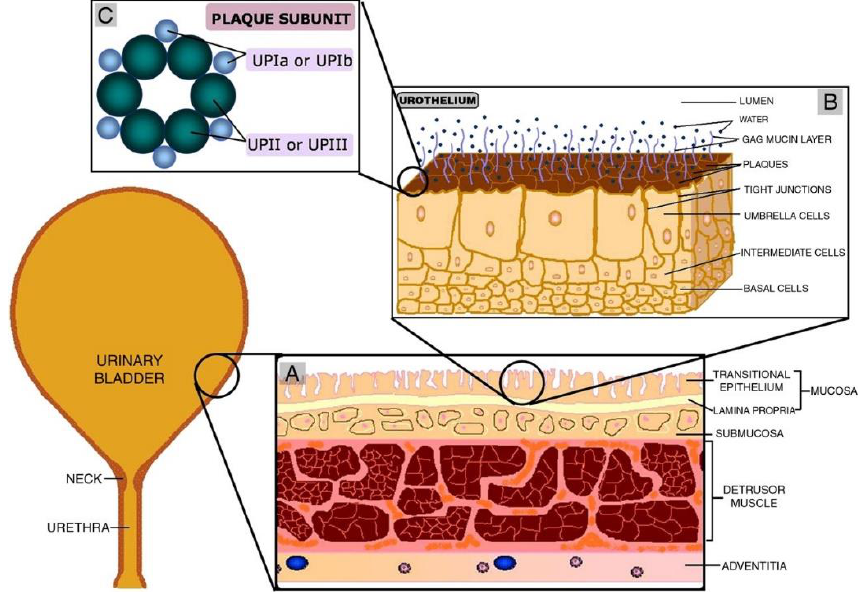
Figure 1. Basic structure of urothelium ( A ). Various layers in the lining of the urinary bladder ( B ) urothelium and ( C ) plaque subunit, that provide the actual permeability barrier. Adopted with permission from [24]; Published by Elsevier, 2010.